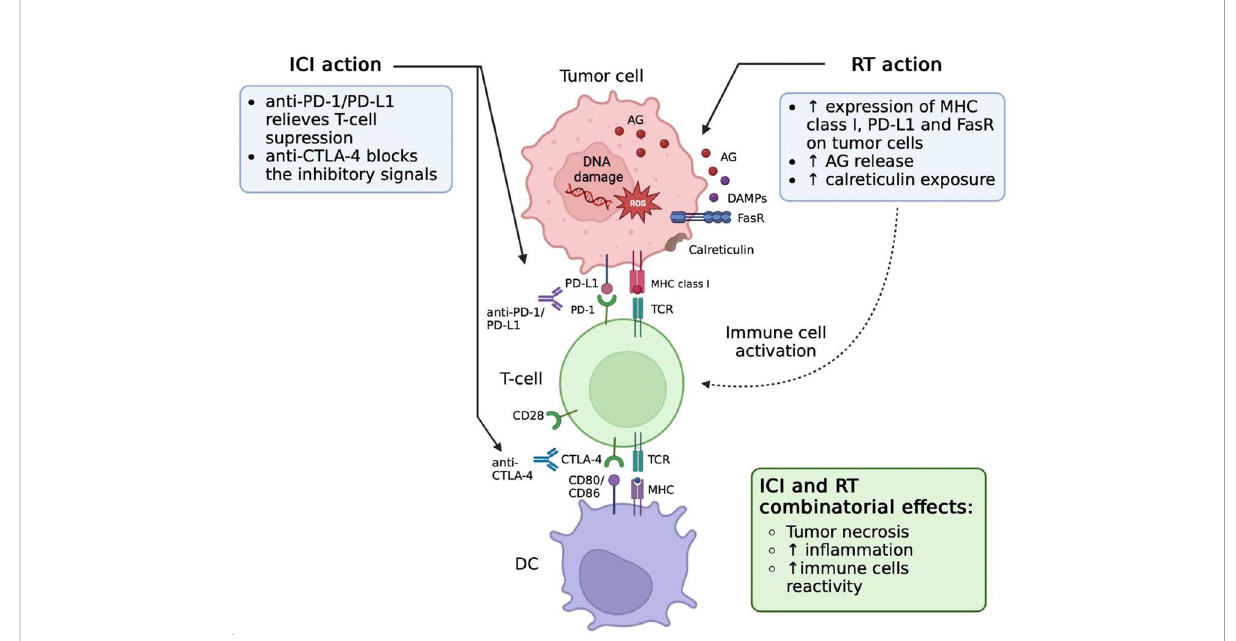
FIGURE 3 Effects of radiation therapy (RT) and immune checkpoint inhibitors (ICIs) combination. RT induces PD-L1 upregulation on tumor cells. Blockade of PD- L1/PD-1 signaling via antibody therapy repairs the function of CD8 T cells after RT stimulation. These functionally active CD8 T cells are able to effectively attack and kill cancer cells, which leads to tumor cell necrosis and in fl ammation increase. AG, tumor-associated antigens; CTLA-4, cytotoxic T-lymphocyte-associated protein 4; DAMPs, damage-associated molecular patterns; DC, dendritic cells; ICI, immune checkpoint inhibitors; MHC,